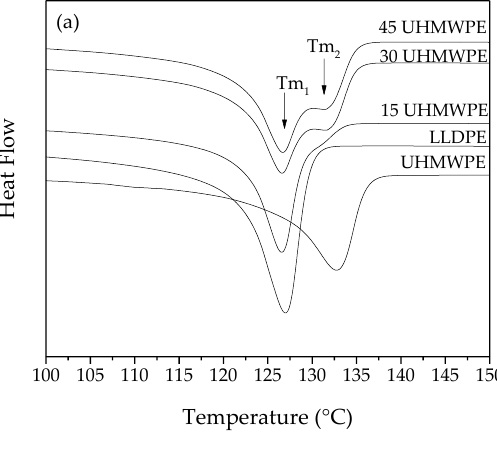
Figure 3. DSC curves of LLDPE, UHMWPE, and the blends: ( a ) first heating, ( b ) second heating, and ( c ) cooling.